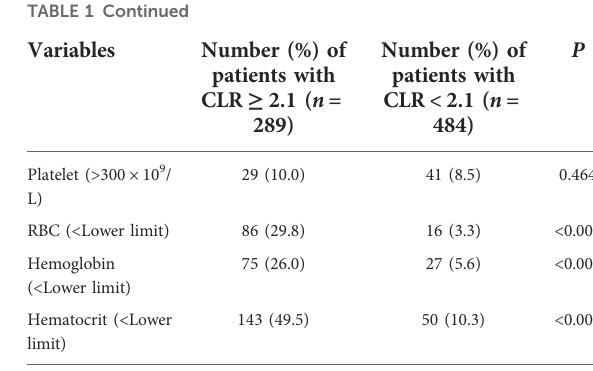
5.5×10 12 /L; hemoglobin reference range: females, 110 – 150 g/L; males, 120 – 160 g/L; hematocrit reference range: females, 35% – 45%; males, 40% – 50%. COPD, chronic obstructive pulmonary disease; CLR, C-response protein to lymphocyte ratio; BMI, body mass index; ASA, American Society of Anesthesiologists; FBG, fasting blood glucose; WBC, white blood cell; RBC, red blood